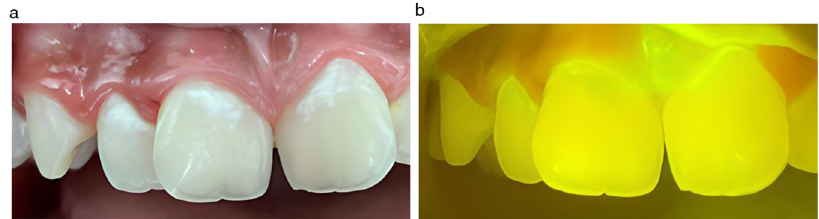
Fig. 1 Photographic image of fl uorescence illumination of active initial caries lesions. The same active initial caries lesions before ( a ) and after ( b ) rinse application.